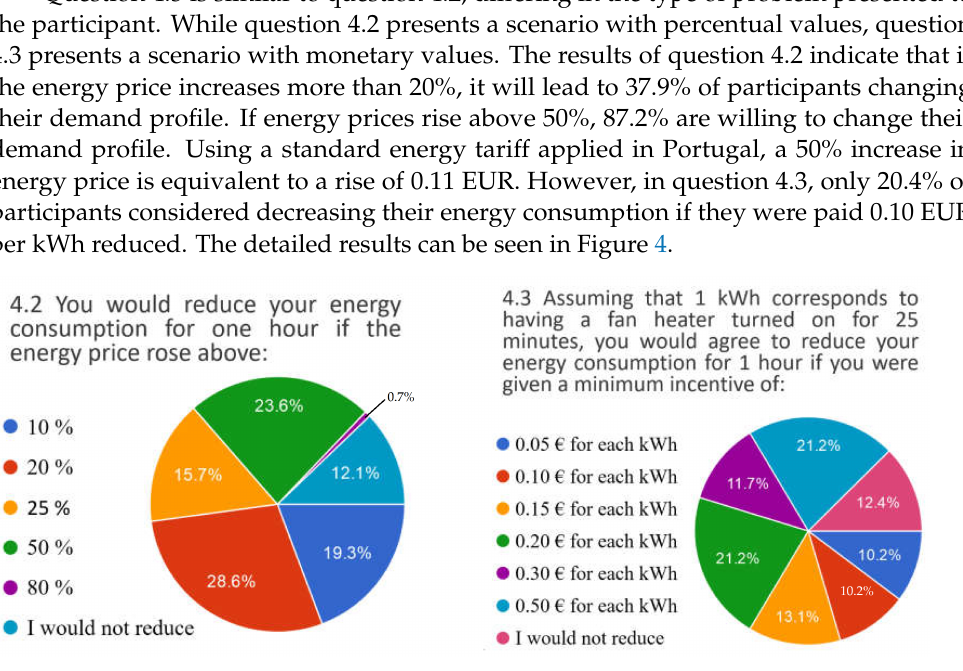
Figure 4. Questions 4.2 and 4.3 replies.